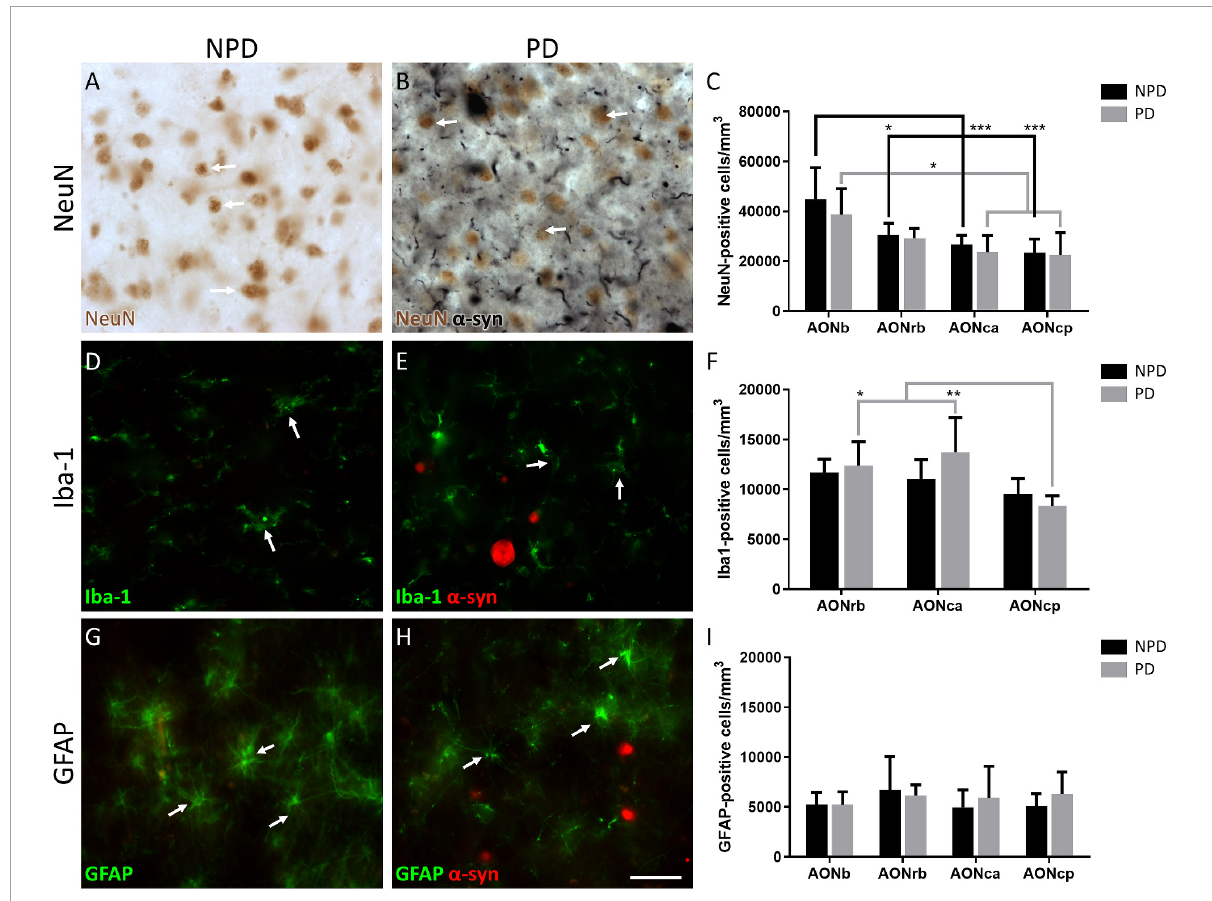
FIGURE2 Quantification of neurons and glia. Representation of the labeling in immunohistochemistry of NeuN (A,B) , immunofluorescence of Iba-1 (D,E) , and GFAP (G,H) . Arrows indicate cell types counted NeuN (A,B) , Iba-1 (D,E) , and GFAP (G,H) . The mean ± SD of NeuN (C) , Iba-1 (F) , and GFAP (I) density in NPD and PD samples. * P -value <0.05, ** P -value <0.01, and *** P -value <0.001. Scale bar = 25